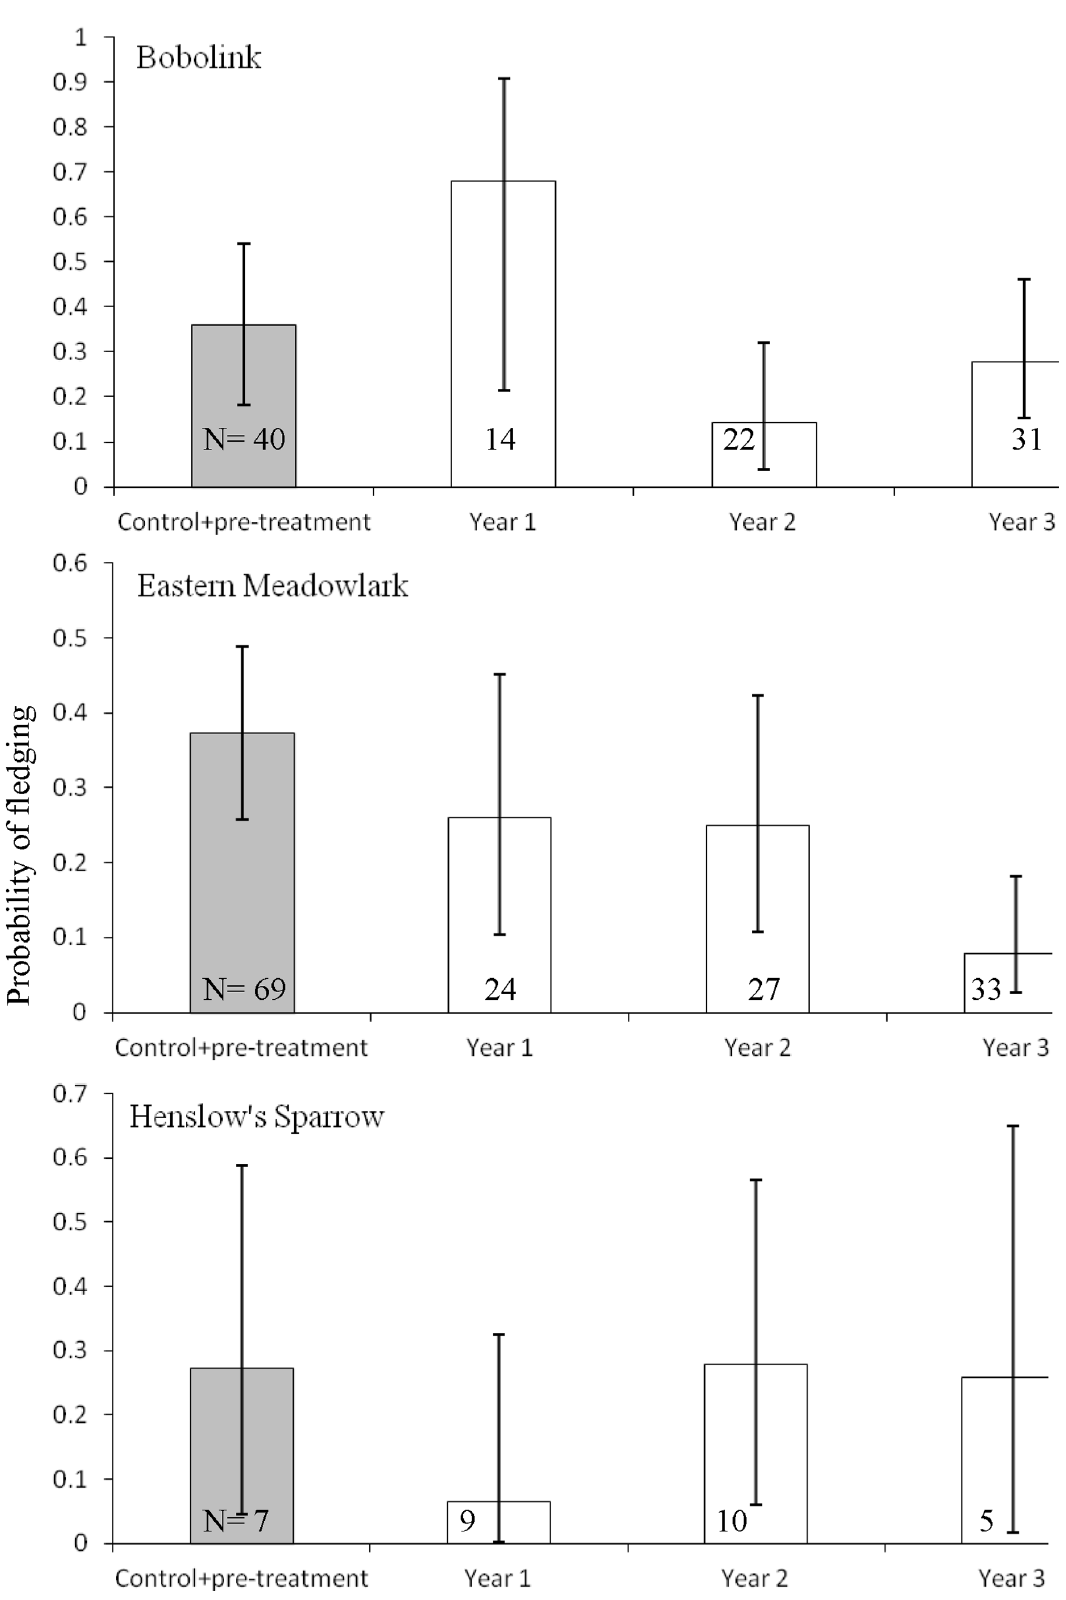
Figure 3. Probability of fledging $ 1 young by species and treatment. Because control and tree row removal sites were paired, the areas and time-periods are comparable. Due to the low number of nests near tree rows (egdes), data were pooled for the control sites and pre-treatment years.